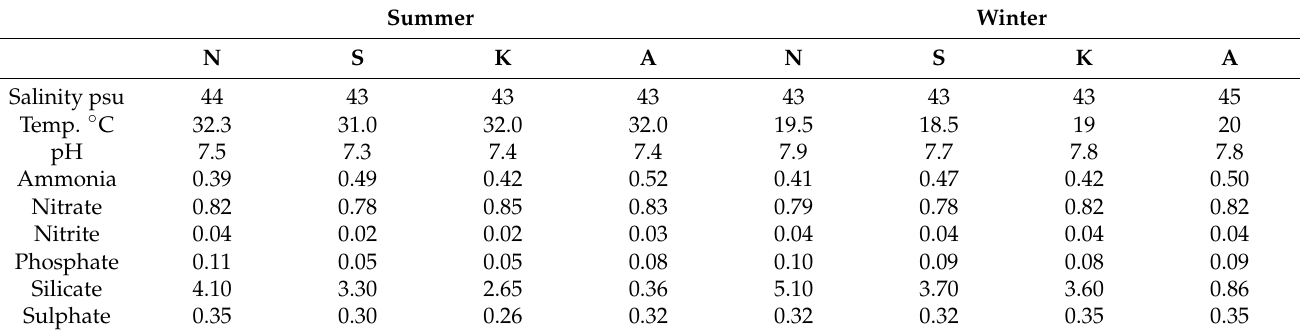
Table 2. Environmental measurements and nutrient concentrations (mg L − 1 ) in the four study areas in the summer and winter seasons (N: Nurana; S: Sayah; K: Karbabad; A: